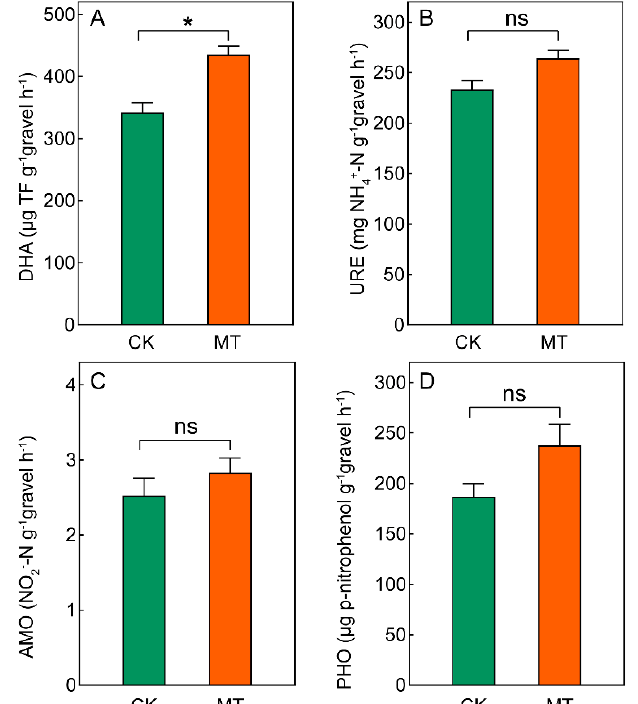
Figure 2. Activities of DHA ( A ), URE ( B ), AMO ( C ), and PHO ( D ) of substrates on the gravel in constructed wetland under control (CK) and melatonin (MT). DHA, dehydrogenase; URE, urease; AMO, ammonia monooxygenase; PHO, phosphatase. “ns” indicates not significant and “*” indicates significance at p < 0.05. Data are expressed as means ± SE (n = 3).